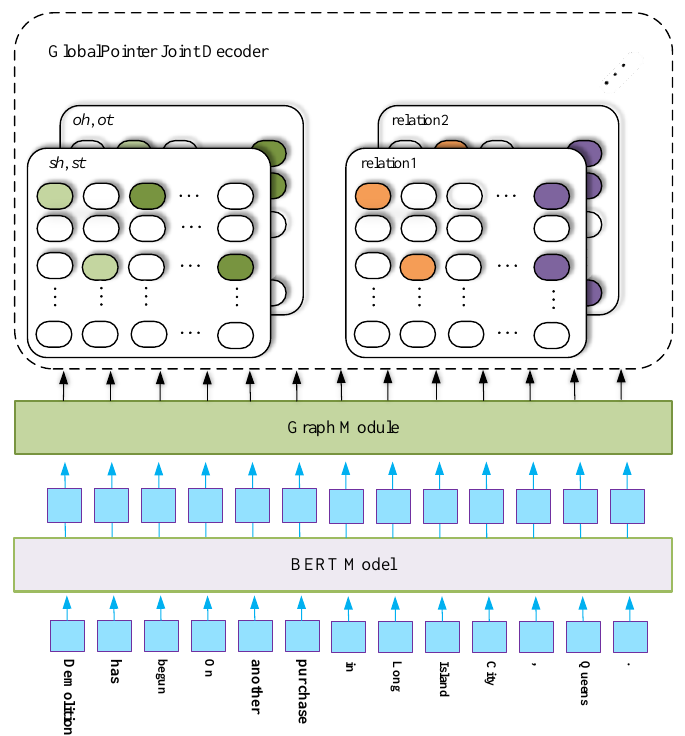
Figure 2. The model of SGNet. It includes the BERT model, graph model, and joint decoding model, where sh stands for subject head, st for subject tail, oh for object head, and ot for object tail.